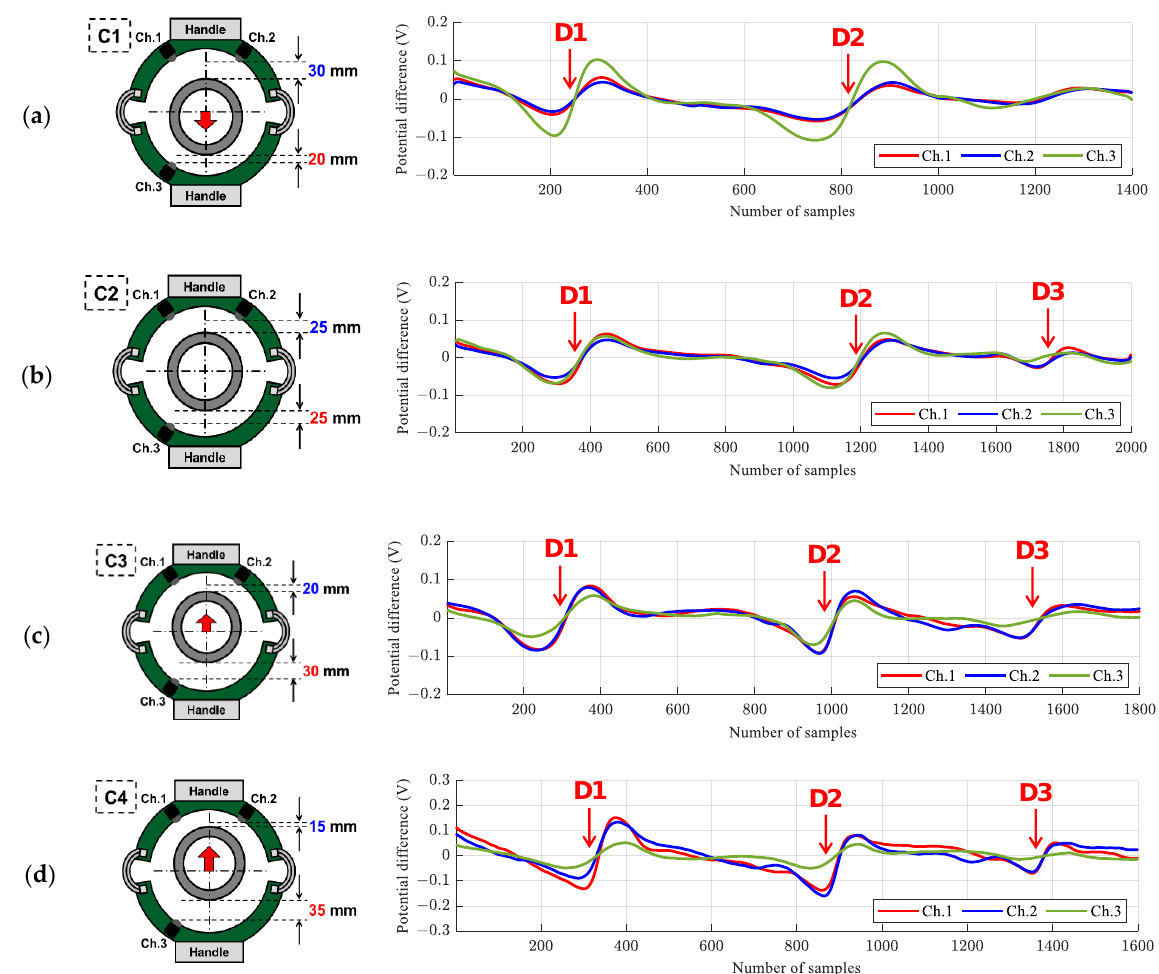
Figure 14. Effects of the liftoff variation on the Hall voltage obtained from the experimental apparatus: ( a ) C1 configuration with 30 and 20 mm offsets from top and bottom sensors, respectively; ( b ) C2 configuration with 25 mm offset from top and bottom sensors; ( c ) C3 configuration with 20 and 30 mm offsets from top and bottom sensors, respectively, and ( d ) C4 configuration with 15 and 35 mm offsets from top and bottom sensors, respectively. Table 4. Experimental results.